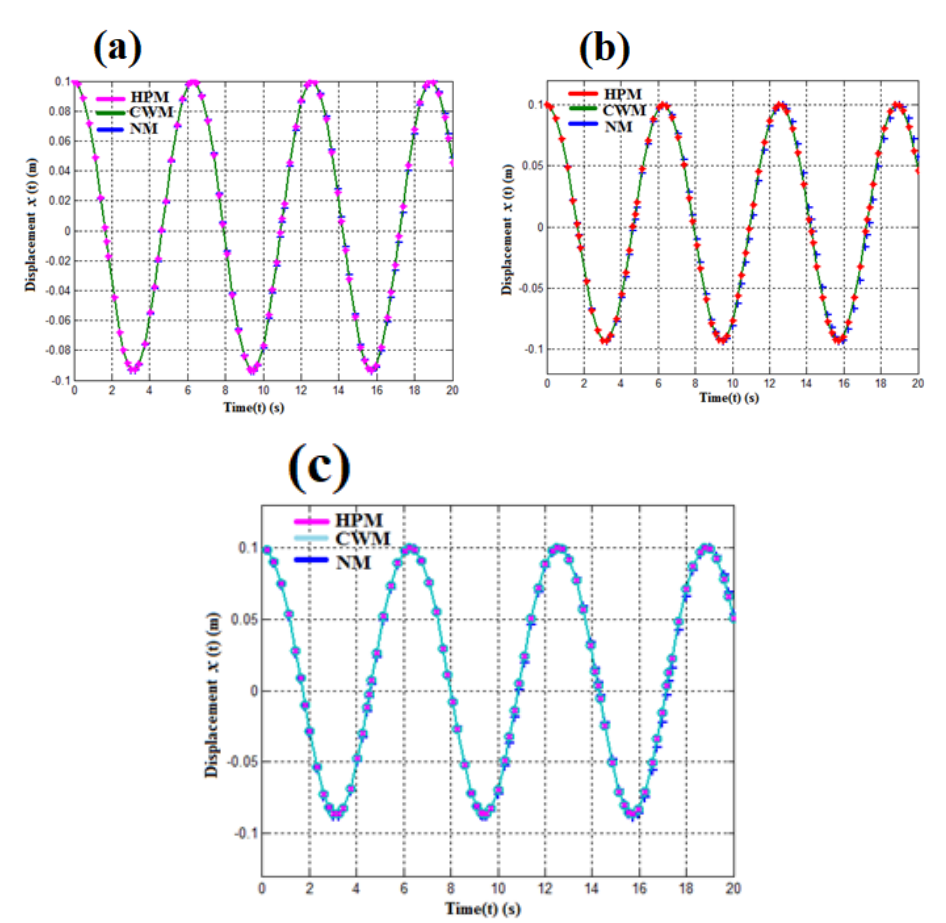
Fig. 3 Comparison of CWM (Eq. (34), HPM (Eq. (35) and numerical method (MATLAB result) for various parameter values. Fig. 3 (a) l = 0 . 1 , α = 1and β = 0 . 5 Fig.3 (b) l = 0 . 1 , α = 1 and β = 2 Fig. 3 (c) l = 0 . 1 , α = 2 and β = 0 . 5 .